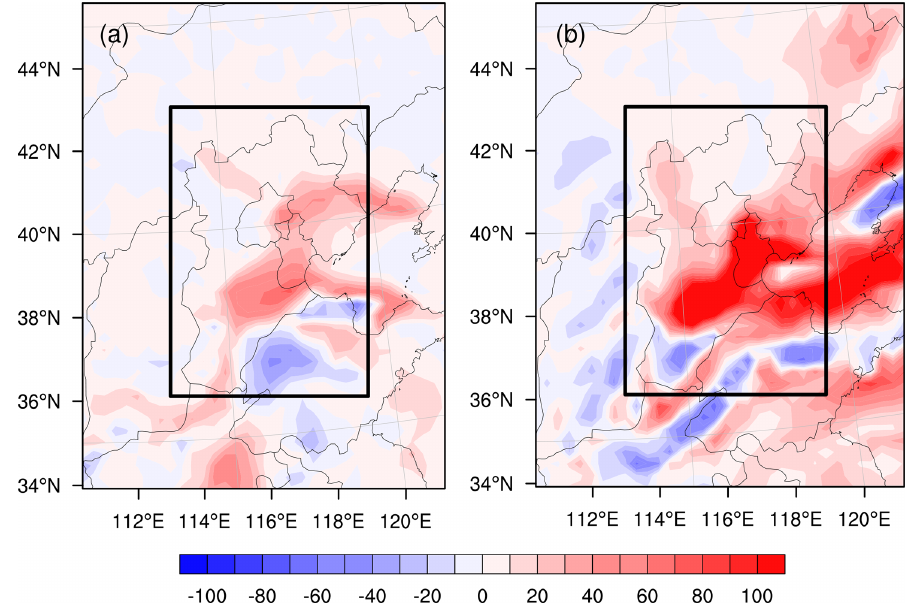
Figure 9. The spatial distributions of the improvement in PM 2 . 5 forecasts (µgm 3 ) at the (a) AT and (b) DT, with a lead time of 24h. The black rectangle is the verification area. Table 3. The same as in Table 2 but for the forecast at the DT. Lead